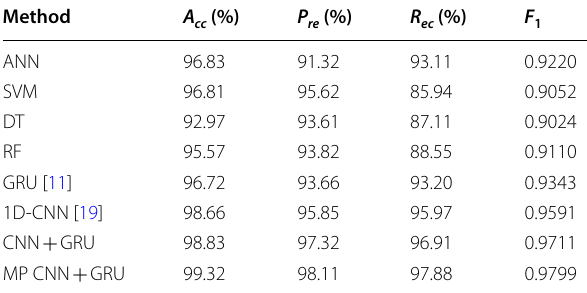
Table 5 TSA result of a single sample on the IEEE